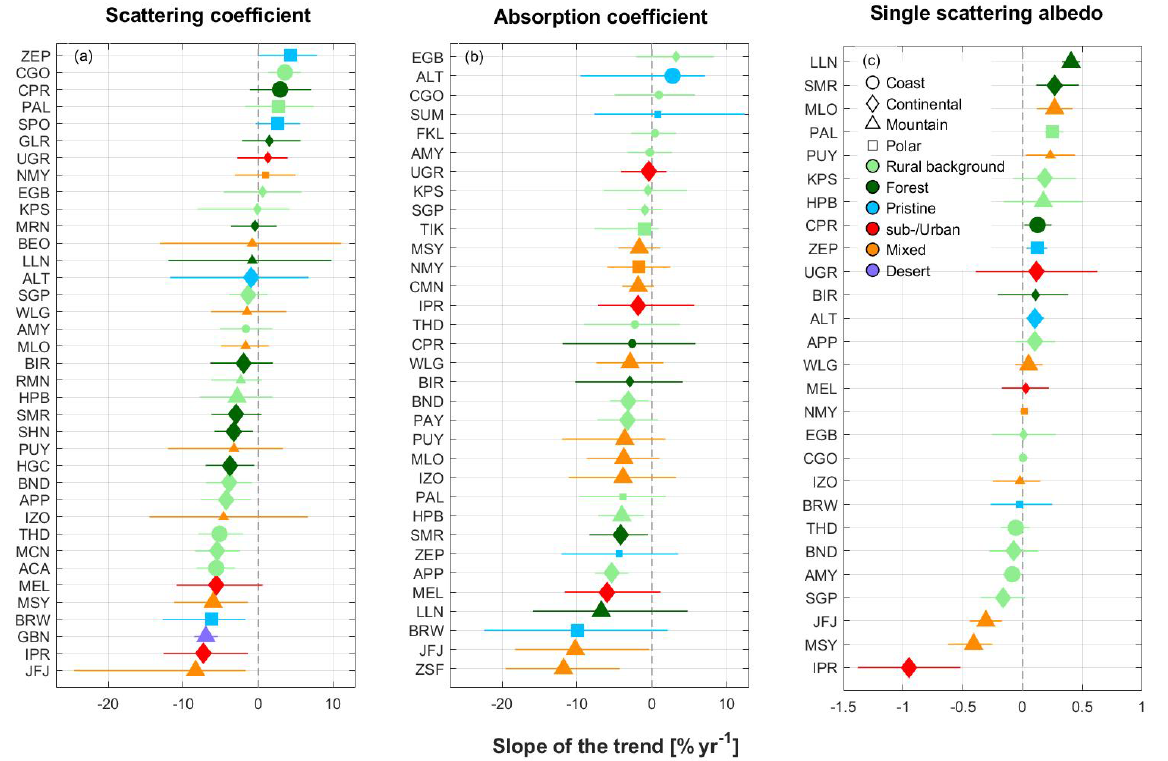
Figure 11. Annual trends for (a) the scattering coefficient, (b) the absorption coefficient, and (c) the single-scattering albedo derived for SARGAN stations providing 10-year time series ending in 2016–2018. The larger symbols represent statistically significant trends at 95% significance level derived from the Mann–Kendall seasonal test Collaud Coen et al., 2020). The lines are the 90% confidence limit upper and lower confidence limits derived from Sen’s slope